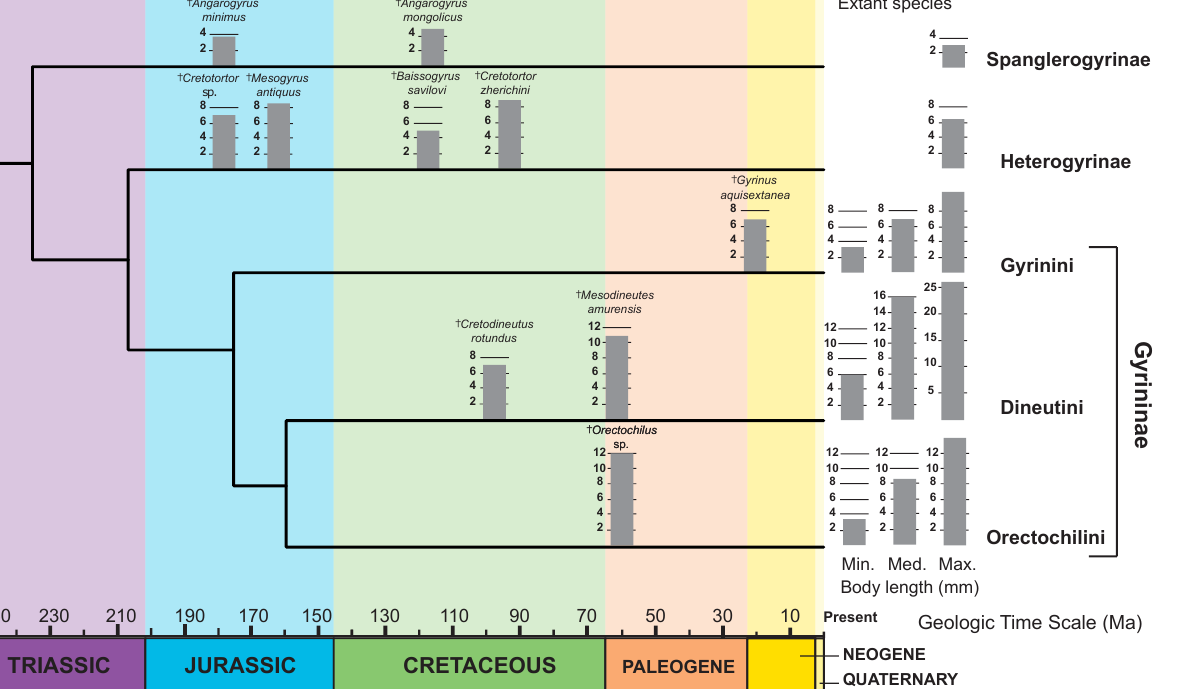
Figure 10. Time calibrated phylogeny showing the evolutionary history of whirligig beetles and their relationships based on Gustafson et al., 2017 [46]. Fossils are placed where they occur in the geologic record based on their median age above the branch of the tree to which they belong. Fossils were chosen from throughout fossil record for each lineage based on whether preservation was enough to estimate body length. The histogram for fossil taxa shows maximum body length, while those for the living species with more than one representative shows the minimum, median, and maximum